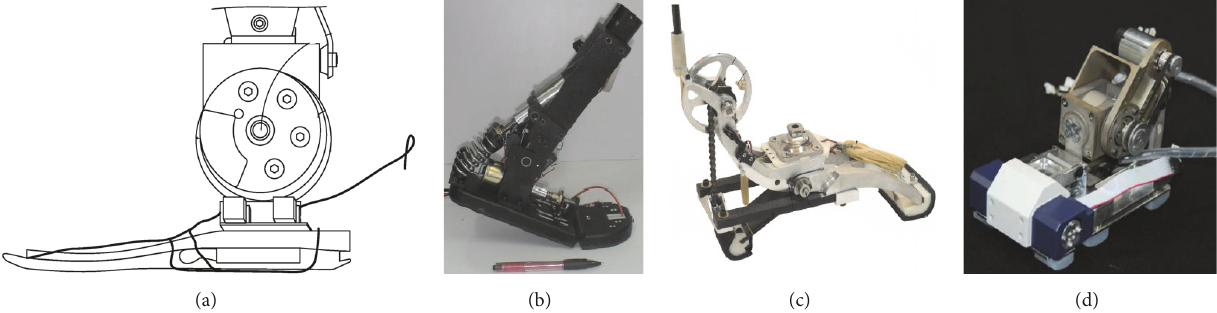
Figure 10: Active and hybrid foot prostheses. (a) Ankle-foot prosthesis of automatic adaptation [16], (b) PANTOE 1 [17, 18], (c) universal prosthesis emulator [19], and (d) parallel four-bar linkage humanoid robot [20].